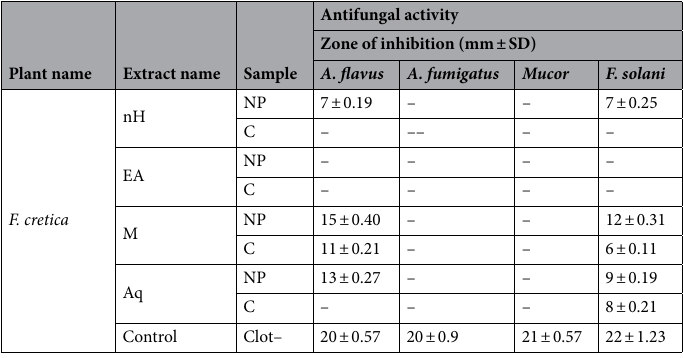
Table 3. Antifungal activity of F.cretica crude extracts and its ZnO nanoparticles. * DMSO = negative control. –- = no activity. Clot = clotrimazole. Values (mean ± SD) are average of triplicate of each test sample (n value of 1 × 3).